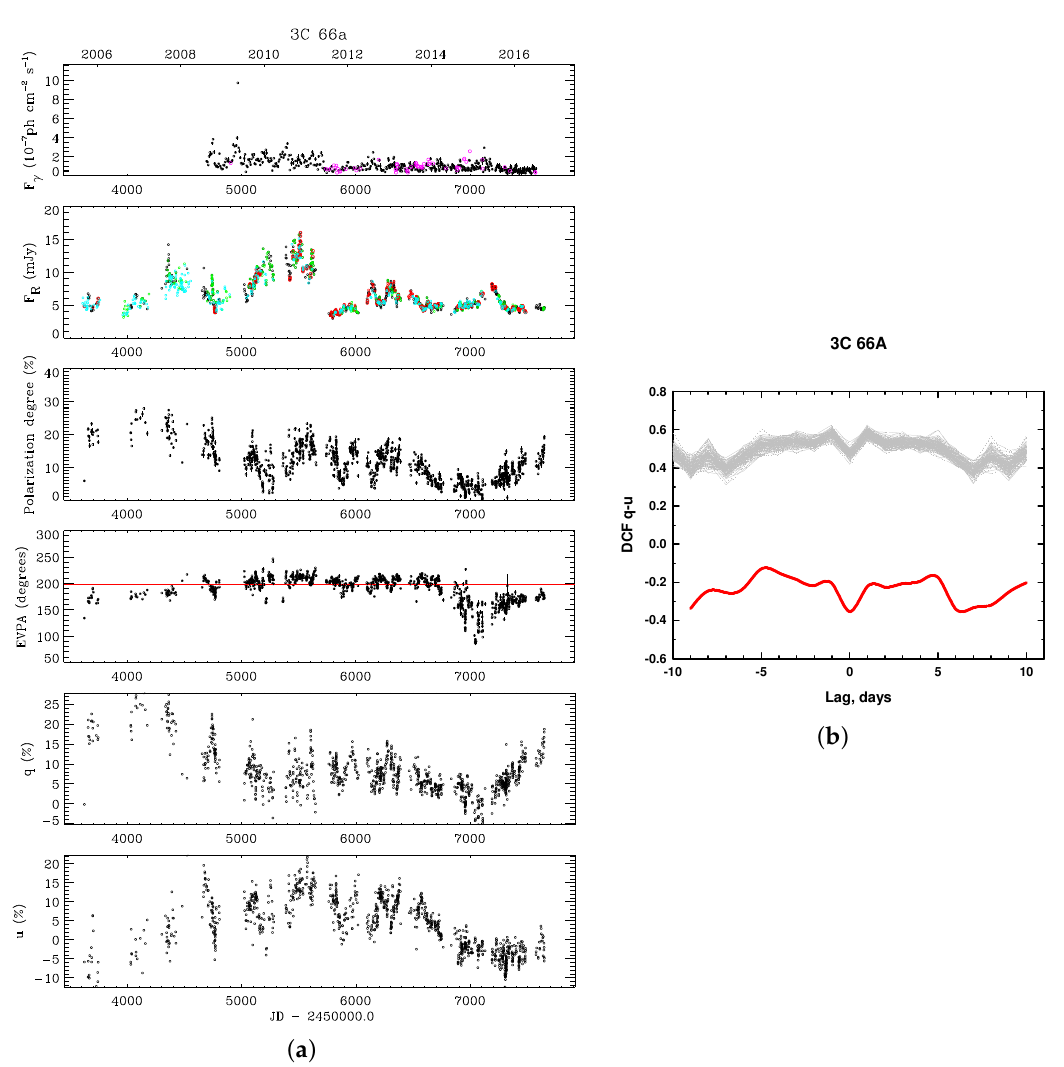
Figure 5. ( a ) From top to bottom: Fermi γ -ray flux, optical R-band flux, optical fractional polarization, position angle of polarization, and normalised Stokes parameters for 3C 66a during 2006–2016; ( b ) Red line—discrete correlation function (DCF) between q and u normalized Stokes parameters for 3C 66a. Gray lines—Monte Carlo simulations under the assumption that no regular rotation of EVPA is